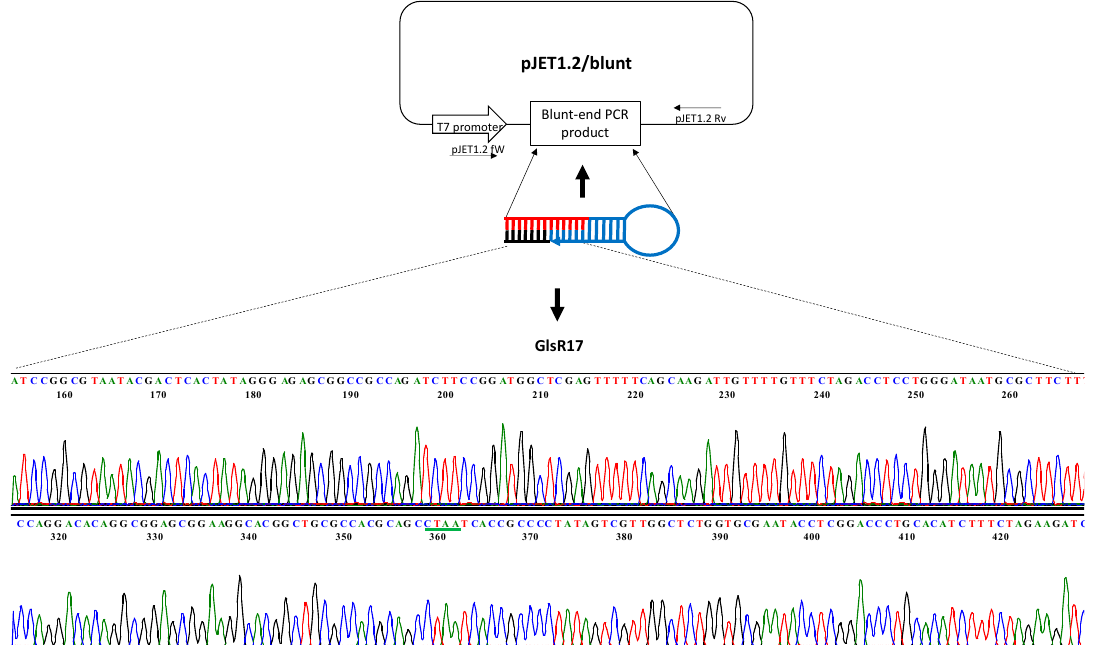
Figure 4. Identification of PCR-amplified fragments of GlsR17 from G . lamblia . PCR-amplified fragments with the primer pairs GlsR17-Fw and UniLoop were cloned into the pJET2.1/blunt vector and sequenced. The corresponding sequence identified the fragment of GlsR17. The green line indicates the sequences of the D box.